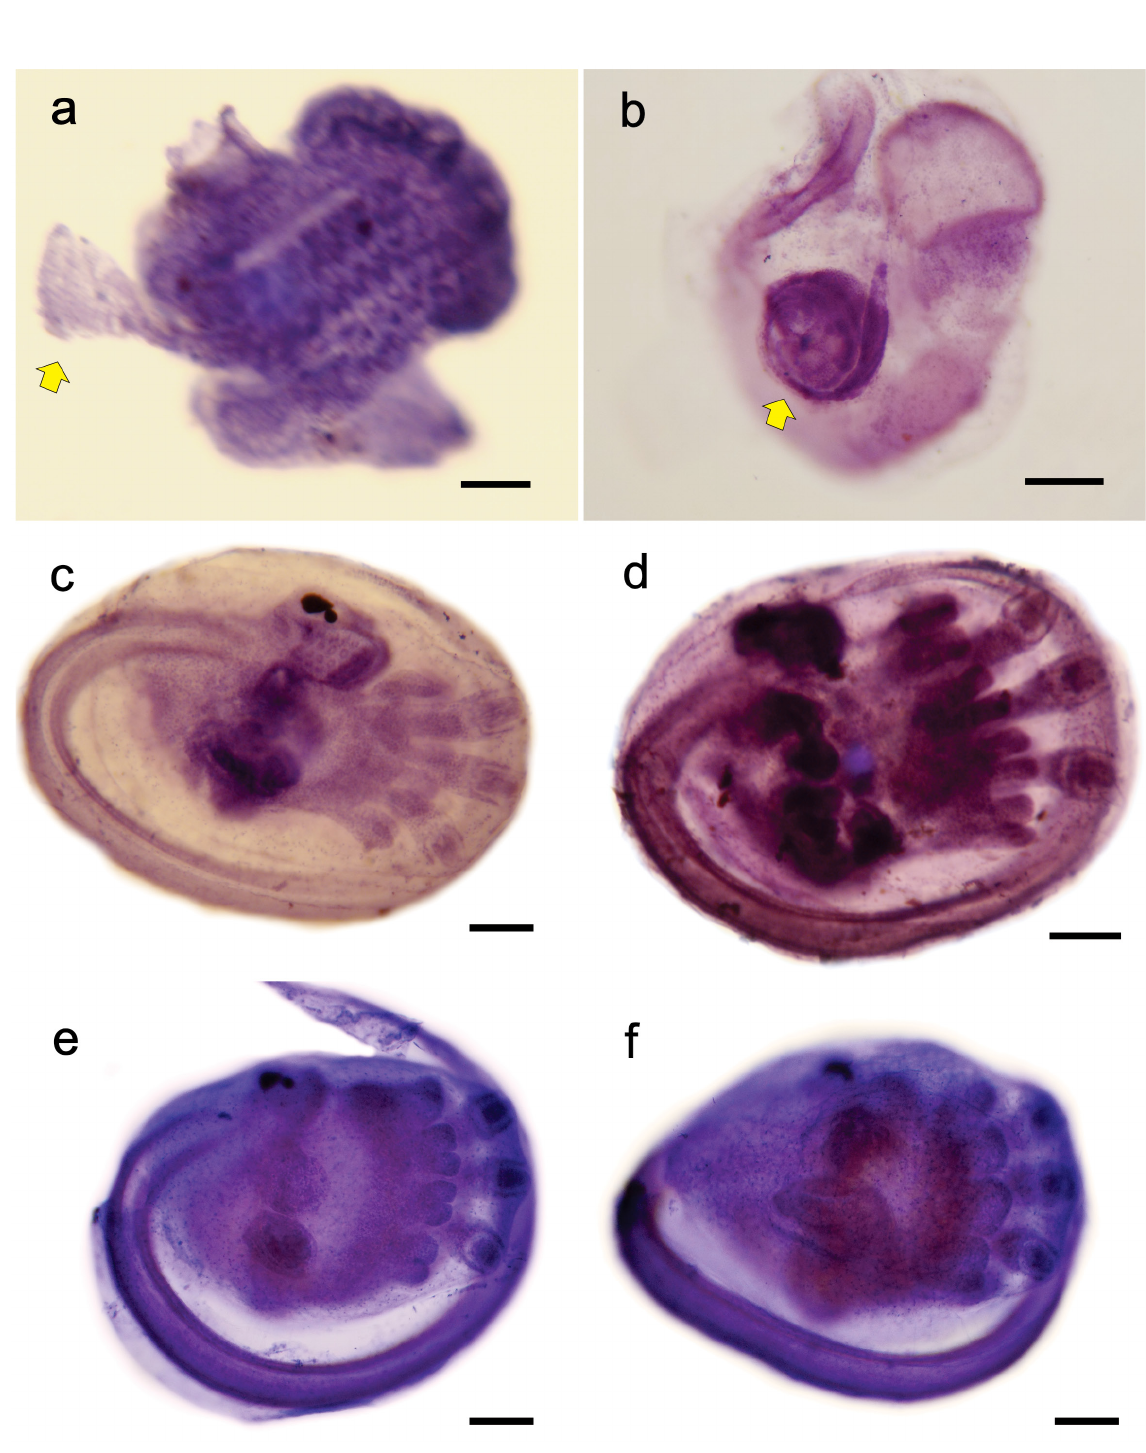
Fig. 4. Polysyncraton amethysteum (Van Name, 1902), Brazil (DZUP DID-034, POSC-016; LIPY UFPB TUN-293). Structures stained with hemalum. a . Thorax, atrial languet (arrow). b . Abdomen showing the position of the testis (arrow). c–f . Larvae in Brazilian specimens from São Paulo (c) and Paraíba (d–f), different stages in the same colony (e–f). Scale bars: 0.1